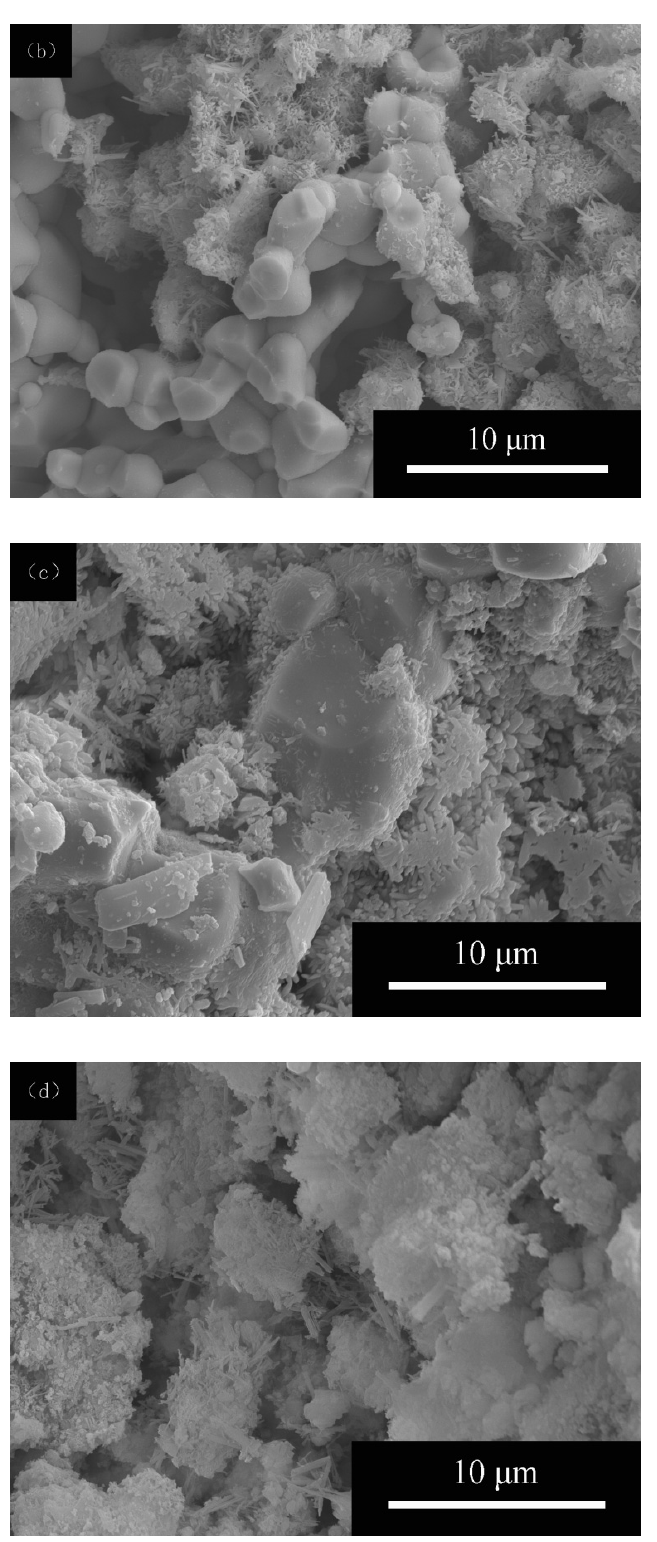
Figure 3. Scanning electron micrographs of ( a ) porous PZT ceramics and PZT–PC composites with water/cement ratios of ( b ) 0.5; ( c ) 0.7; ( d ) 0.9.